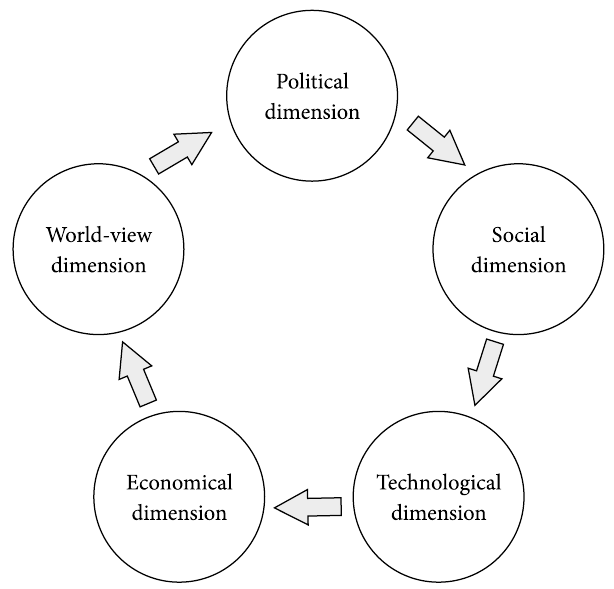
Fig. 2. Interactions of environmental